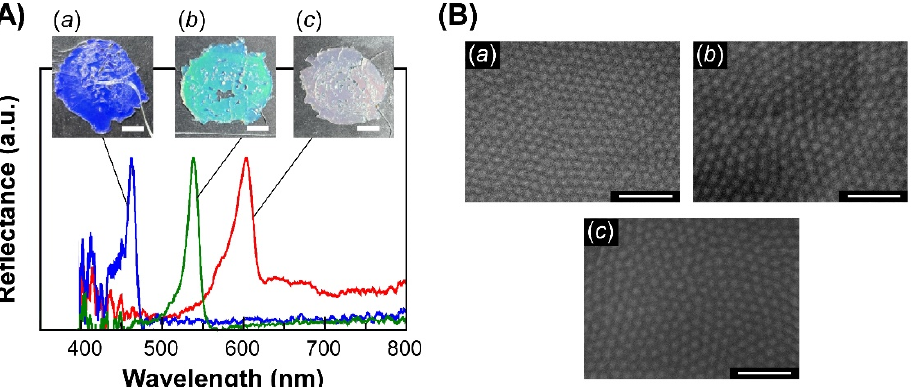
Figure 3. Reflection characteristics of CC films of three kinds of SiP-POAs with different molecular weights of POA chains. ( A ) Reflection spectra of CC films of SiP-POA109k ( a ), SiP-POA191k ( b ) and SiP-POA278k ( c ) fabricated by hot-pressing at 100 °C. Insets represent the reflection images of CC films, and the white scale bars signify 5 mm. ( B ) SEM images of the CC film surfaces of SiP-POA109k ( a ), SiP-POA191k ( b ) and SiP-POA278k ( c ) observed from the top view. White scale bars signify 1 µ m.